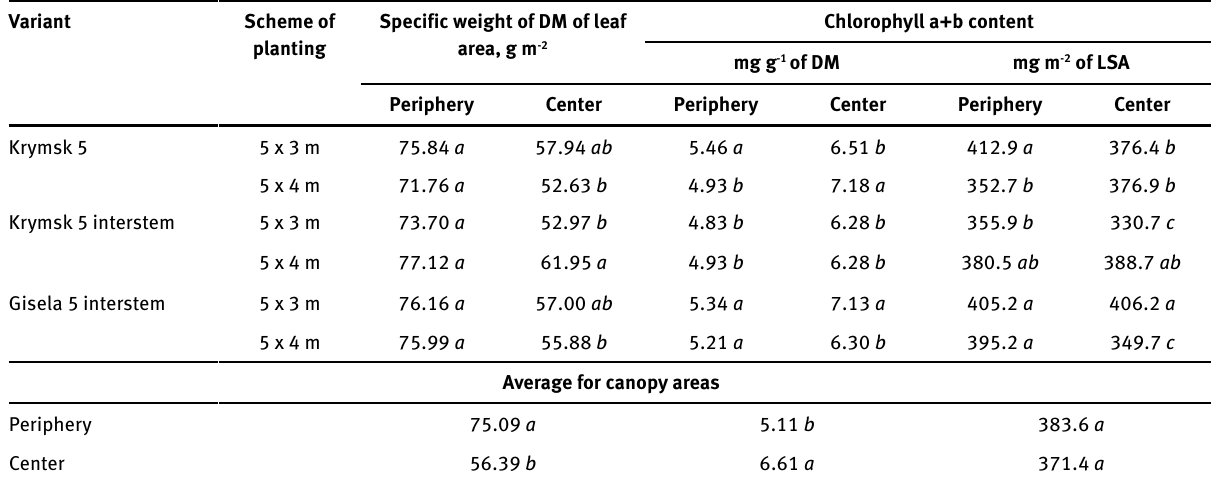
Table 2: Chlorophyll content in sweet cherry leaves depending on the zone of the canopy, average for cultivars, 2016-2017 Variant Scheme